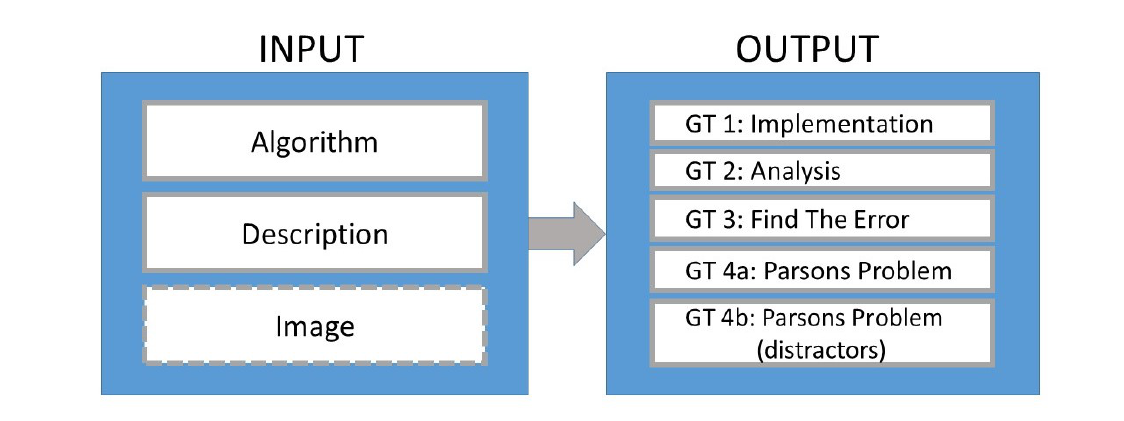
Figure 1. The basic idea for the Generic Tasks (GTs) for